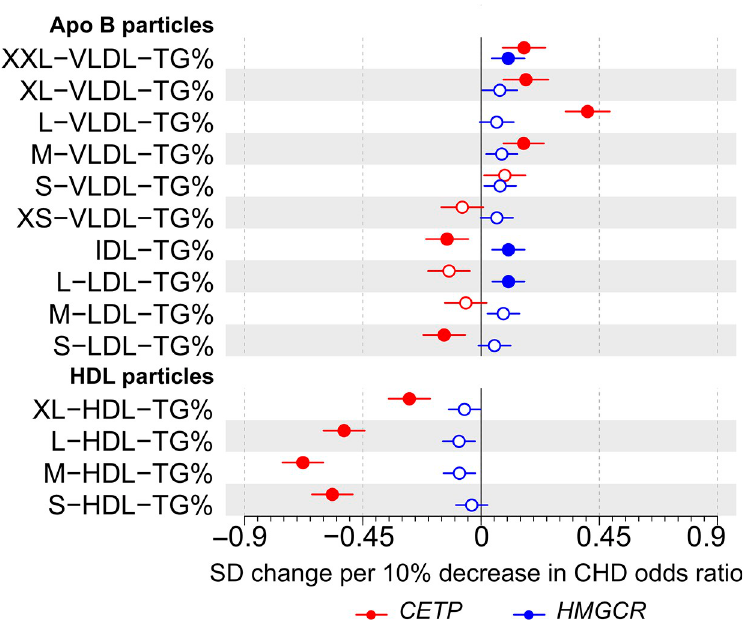
Fig 4. Associations of genetic variants in CETP rs247617 (red) and HMGCR rs12916 (blue) with the triglyceride composition of size-specific lipoprotein particles. Estimates represent the standardized difference in lipoprotein trait, with per allele associations scaled to a 10% lower relative risk of CHD. Analyses were adjusted for age, sex, genotyping batch, and 10 genetic principal components. The circles refer to the effect estimates and the horizontal bars to the 95% CIs. Closed circles represent statistical significance of associations at P < 0.002 and open circles associations that are nonsignificant at this threshold. The lipoprotein subclasses are defined by particle size [17–19]: potential chylomicrons and the largest VLDL particles (XXL-VLDL; average particle diameter � 75 nm); 5 different VLDL subclasses, i.e., very large (average particle diameter 64.0 nm), large (53.6 nm), medium (44.5 nm), small (36.8 nm), and very small (31.3 nm); IDL (28.6 nm); and 3 LDL subclasses, i.e., large (25.5 nm), medium (23.0 nm), and small (18.7 nm). The 4 size-specific HDL subclasses are very large (average particle diameter 14.3 nm), large (12.1